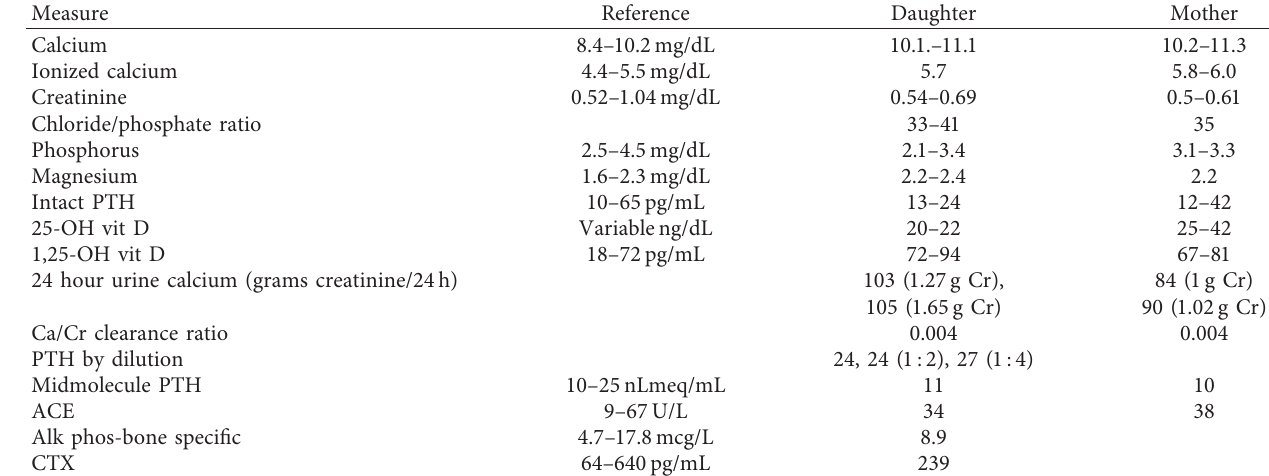
Table 1: Range of values displayed when numerous results are